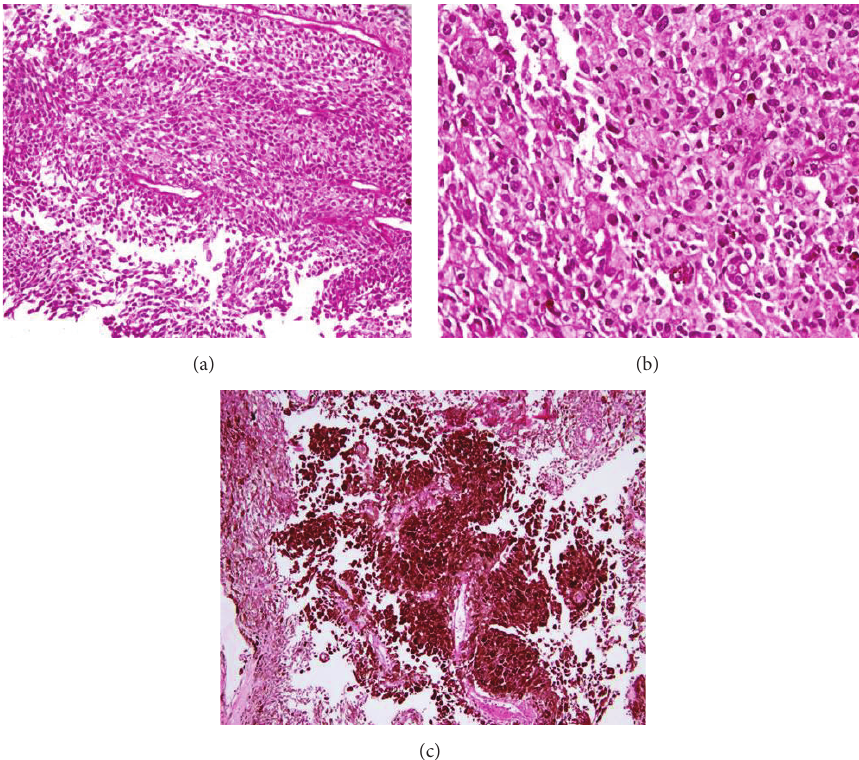
Figure 5: Histopathological examination. (a) Diffusely pigmented tumor with peritheliomatous arrangement which obscured the cytological details (H and E 40x). (b) After bleaching, tumor had pleomorphic round to oval nuclei with inconspicuous nucleoli and moderate amount of cytoplasm (H and E 40x). (c) Tumor on higher magnification had mild nuclear pleomorphism, moderate to abundant cytoplasm with few containing blackish brown pigment. No significant increase in mitosis was seen (H and E